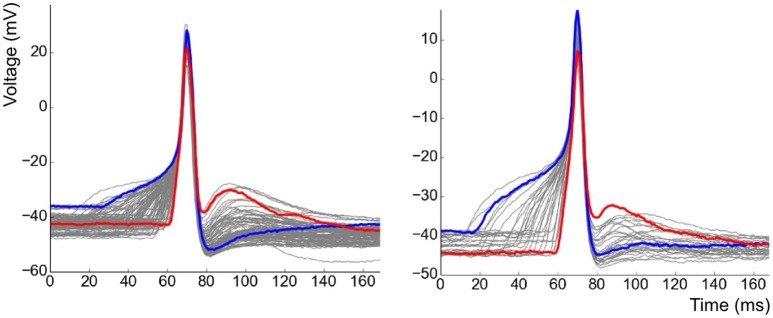
Collection of all APs observed in two of the cells superimposed over one another. Examples of strongly contrasting shapes have been highlighted in each case.